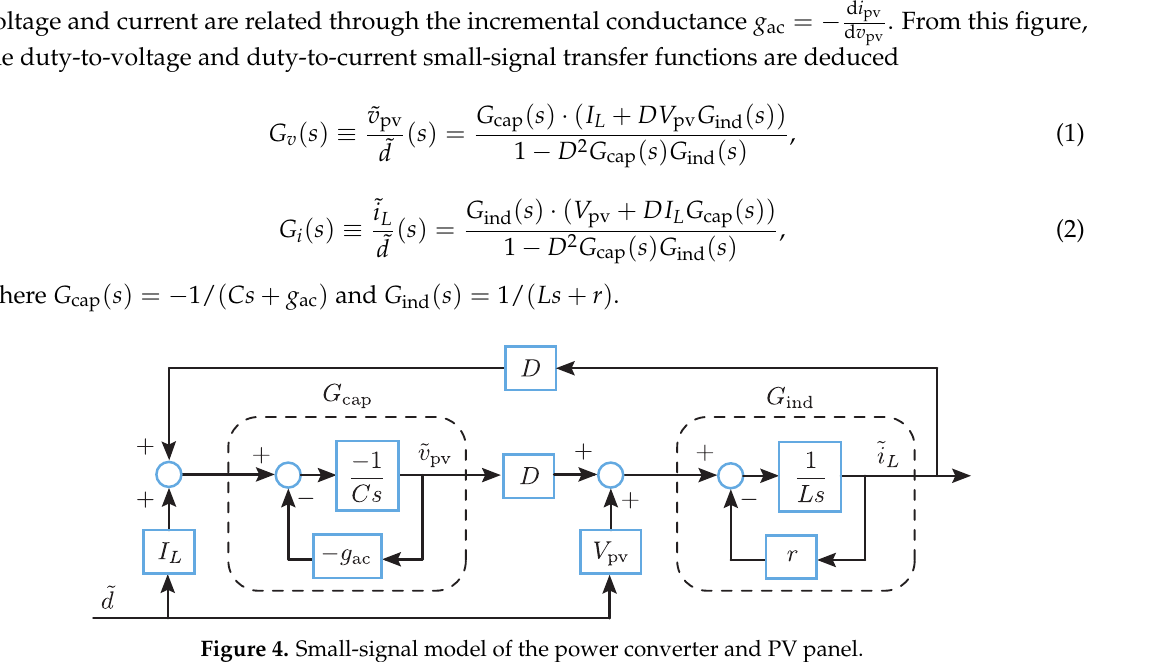
Figure 4. Small-signal model of the power converter and PV